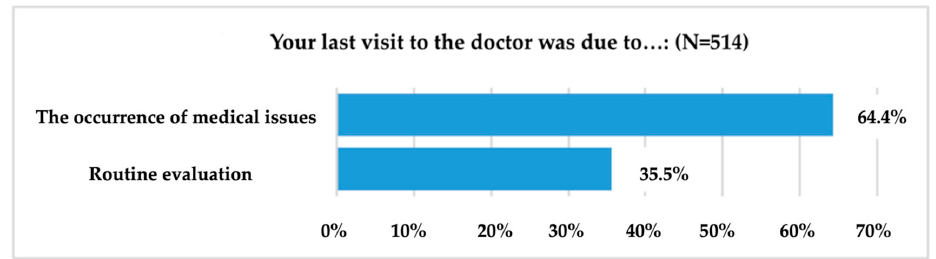
Figure 2. The determining reason for the last visit to the doctor.